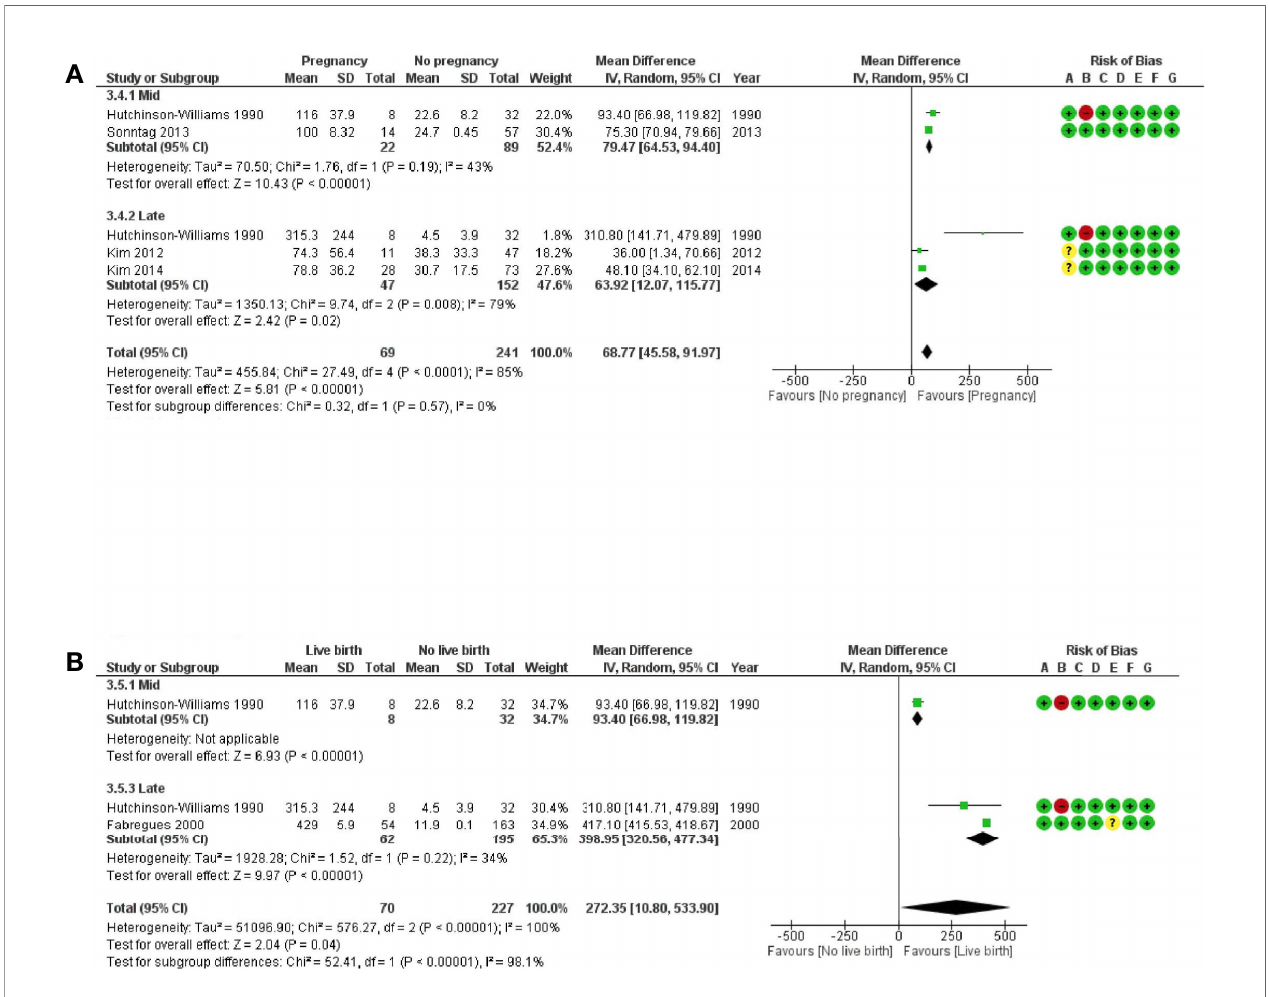
FIGURE 3 | Forest plots of studies “ no corpus luteum ” according to the route of progesterone administration for (A) ongoing pregnancy and (B) live birth. Risk of bias legend: 1, confounding; B , selection of patients; C , classi fi cation of intervention; D , deviations from intervention; E , missing data; F , measurement of outcome; G , selection of reported